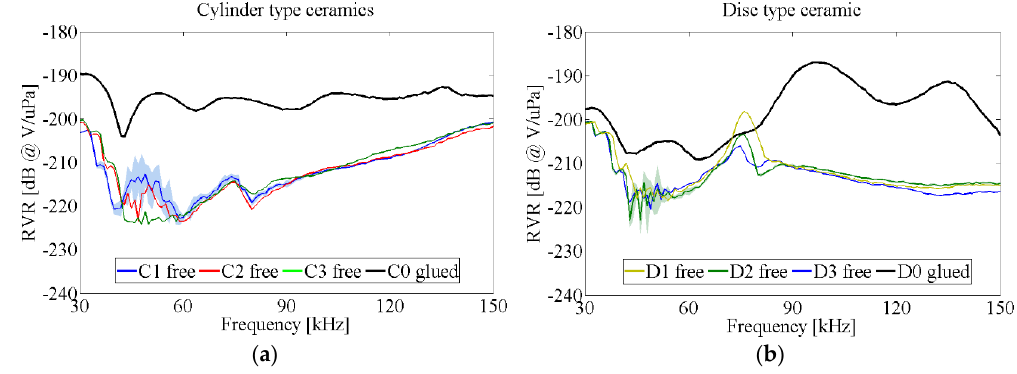
Figure 9. RVR of ceramics in configurations 1 (free) and 2 (glued). As an example, the shadowed area shows the uncertainties for a ceramic of each type, being quite similar for the rest of ceramics. The uncertainties are small for frequencies above 60 kHz, less than 1 dB, but it may be larger, up to 5 dB, for frequencies below 60 kHz. ( a ) Cylinder type ceramic; ( b ) Disc type ceramic.